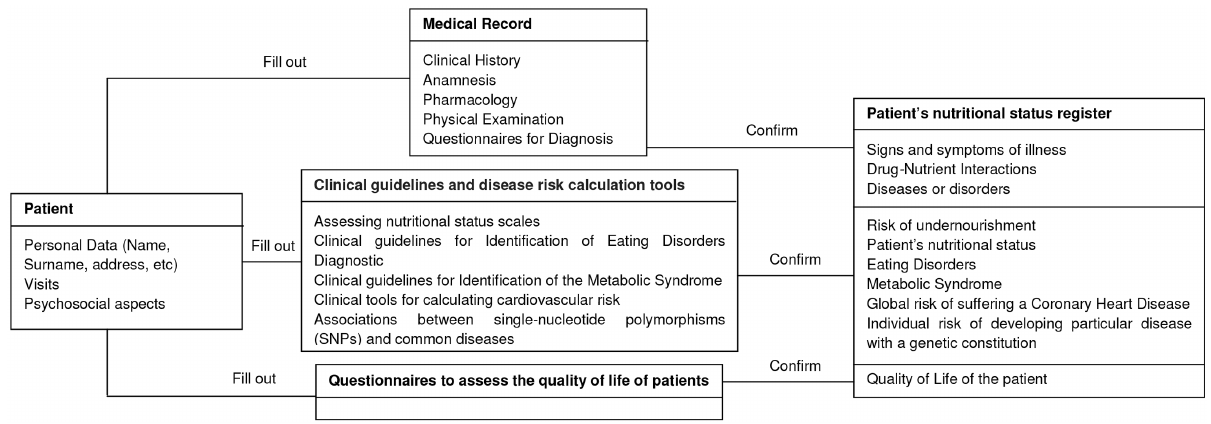
Fig 3. Diagram of the operational processes of the Computer Assisted